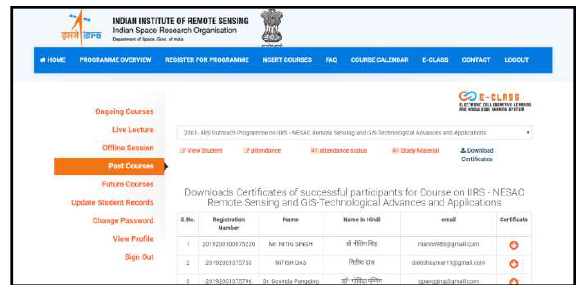
Figure 10. Course specific certificate download section at the IIRS E- learning portal